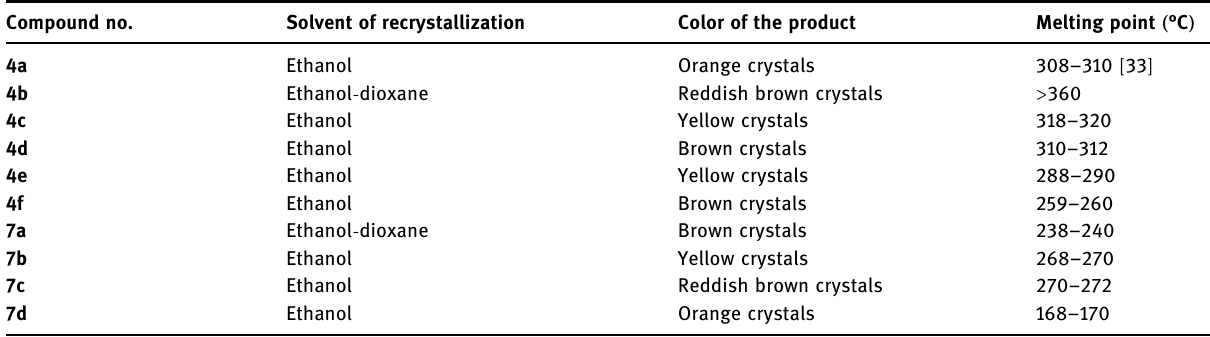
Table 1: Description of synthesized products 4a – f and 7a – d Compound